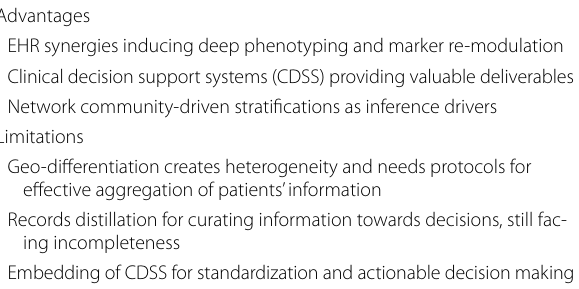
Table 3 Pros and Cons of